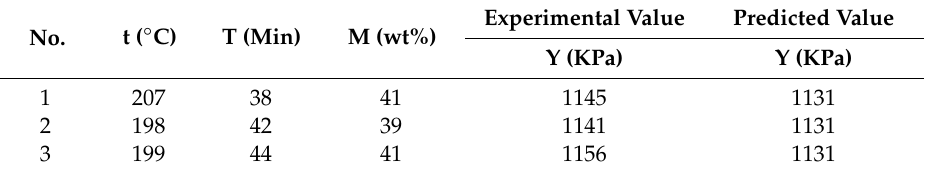
Table 4. Experimental and predicted values for adhesion strength (Y) in the validation experiments.